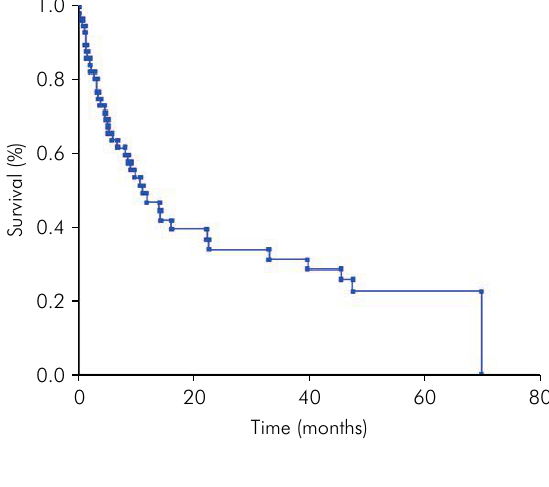
Figure 3. Kaplan–Meier graphic with overall survival